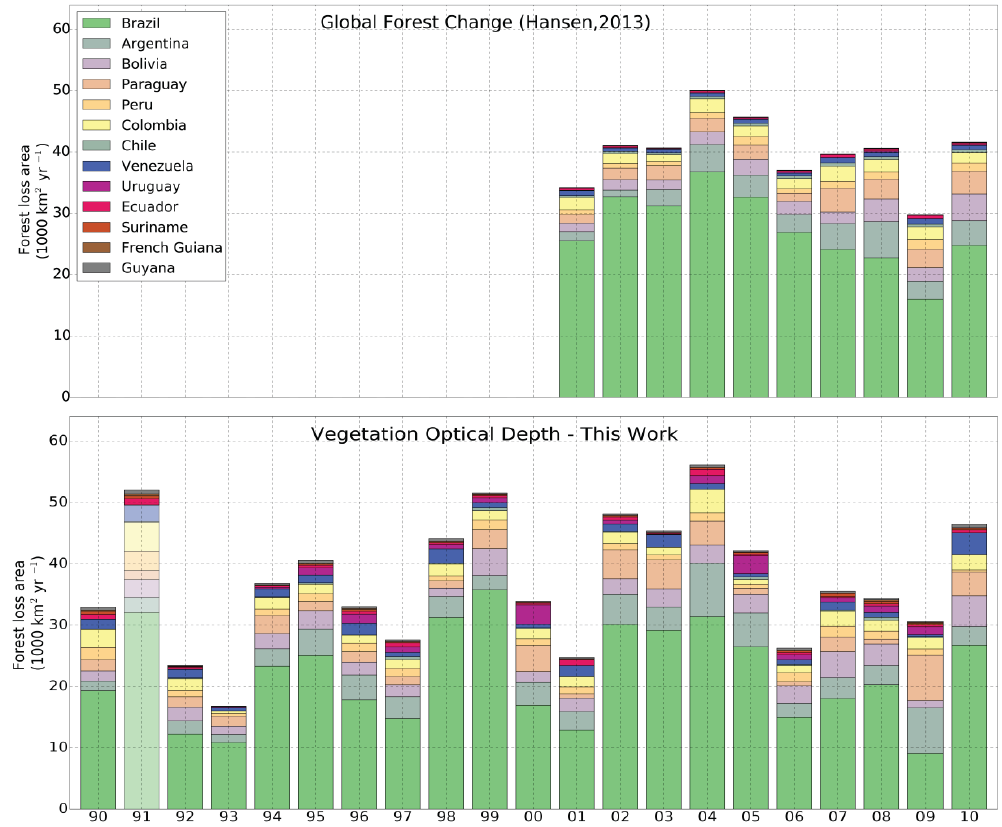
Figure 7. Country-level time series of annual totals of forest loss according to GFC (2001–2010) and VOD (1990–2010). VOD data are unreliable for 1991 as a result of the eruption of Mount